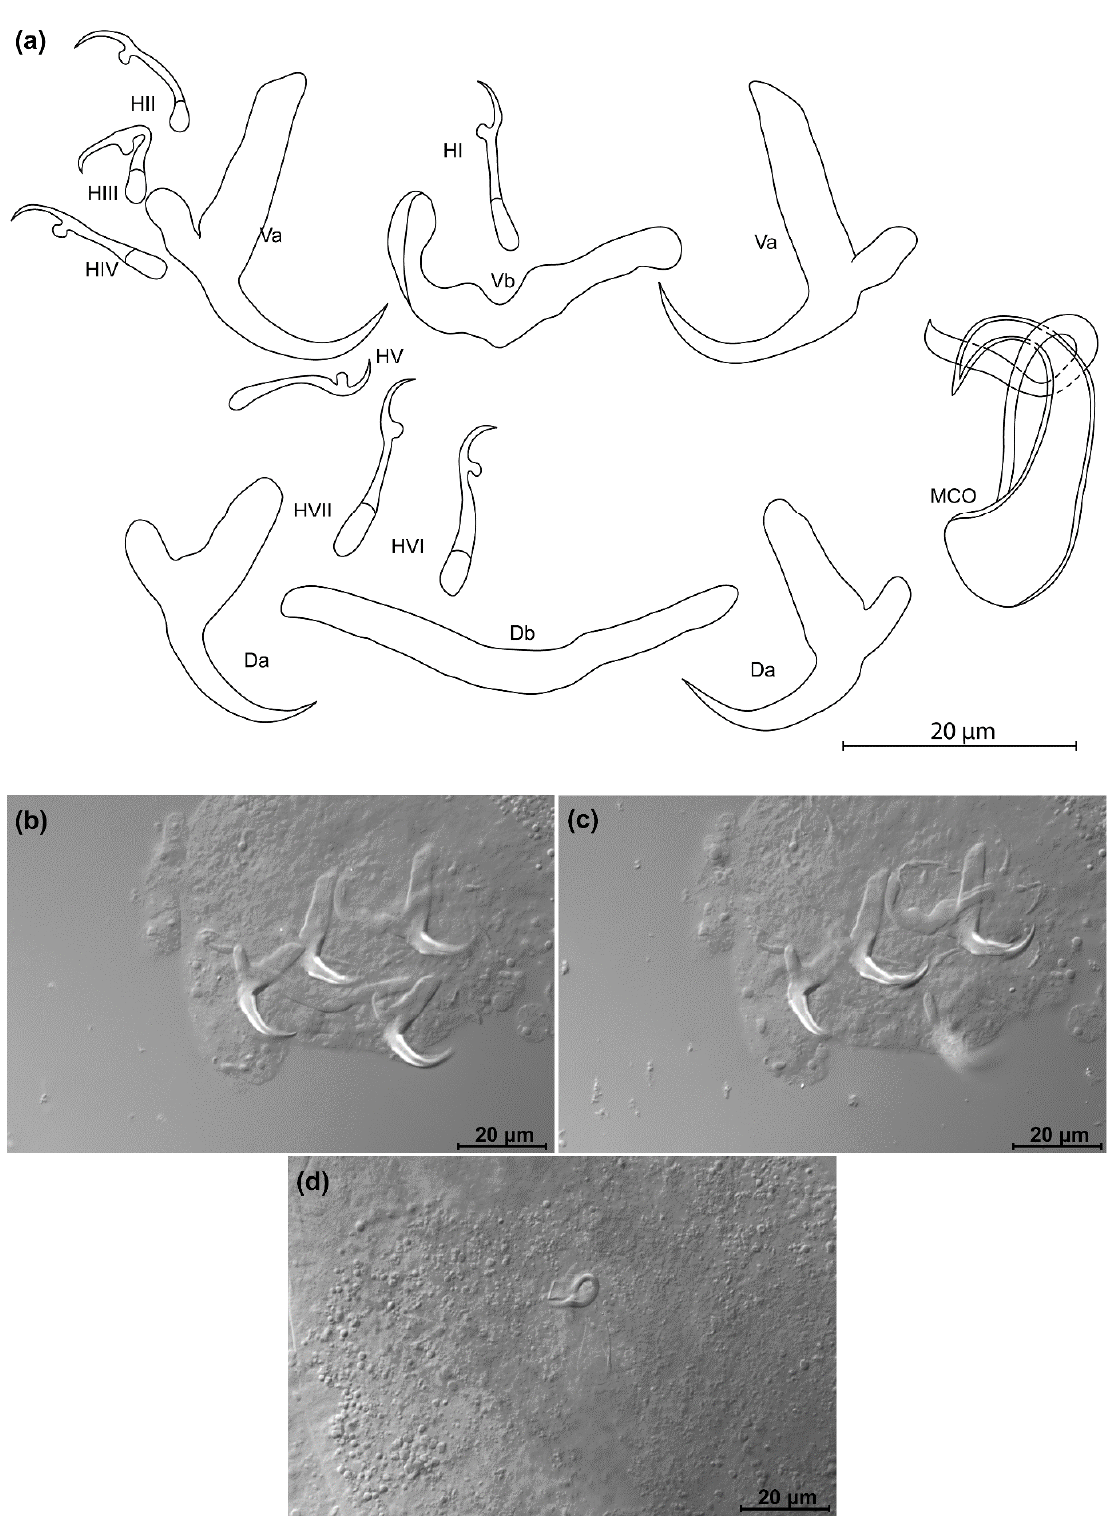
Figure 9. Kapentagyrus parisellei n. sp. (ex Nannothrissa parva ). ( a ) Drawings of sclerotized structures, Va-ventral anchors, Da-dorsal anchors, Db-dorsal bar, Vb-ventral bar, H-hooks (pairs I to V—ventral; pairs VI, VII—dorsal), MCO-male copulatory organ. ( b ) Micrograph of dorsal and ventral anchors, dorsal bar. ( c ) Micrograph of ventral anchors and ventral bar. ( d ) Micrograph of MCO.